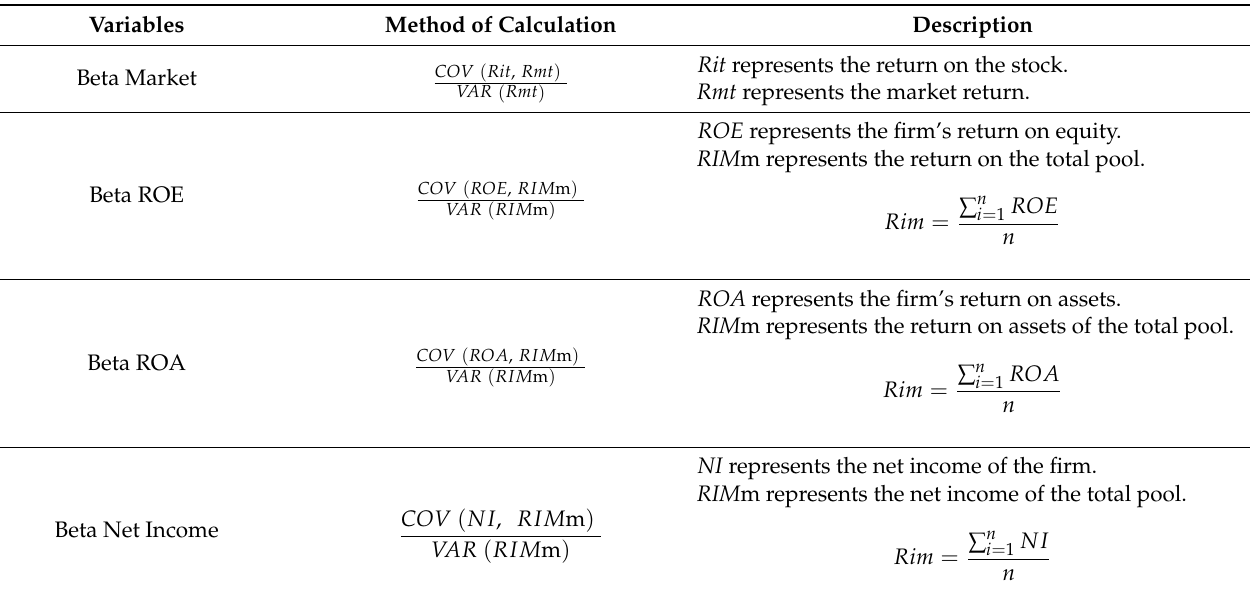
Table 1. Definitions of variables. Variables Method of